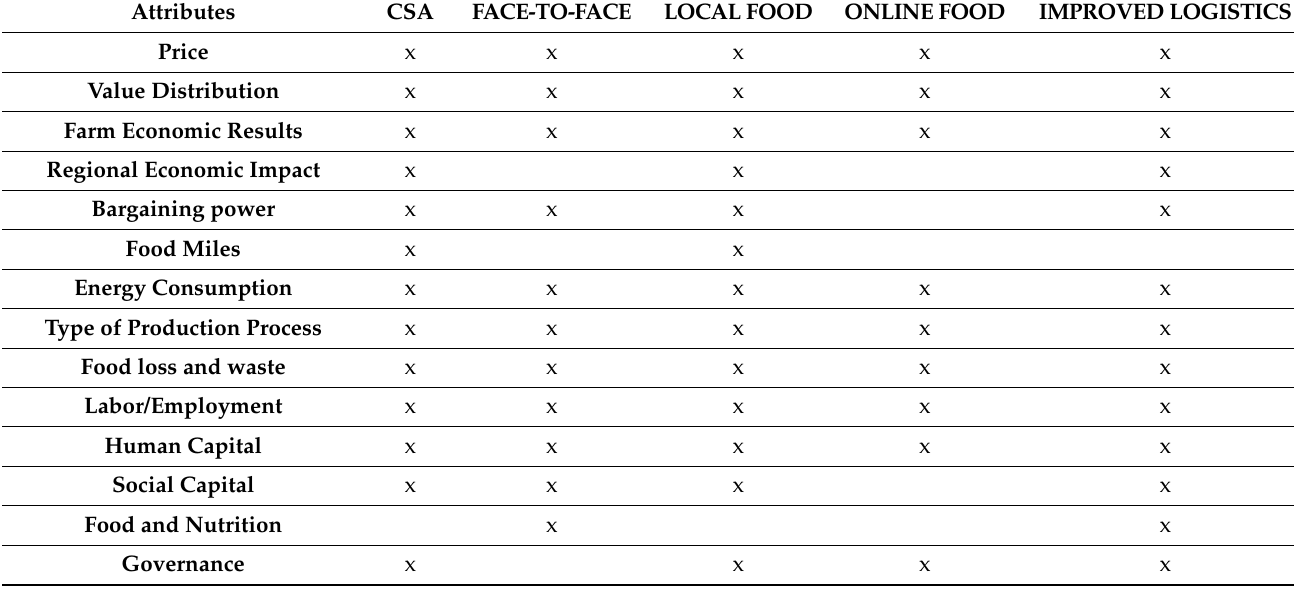
Table 6. Business models’ performance